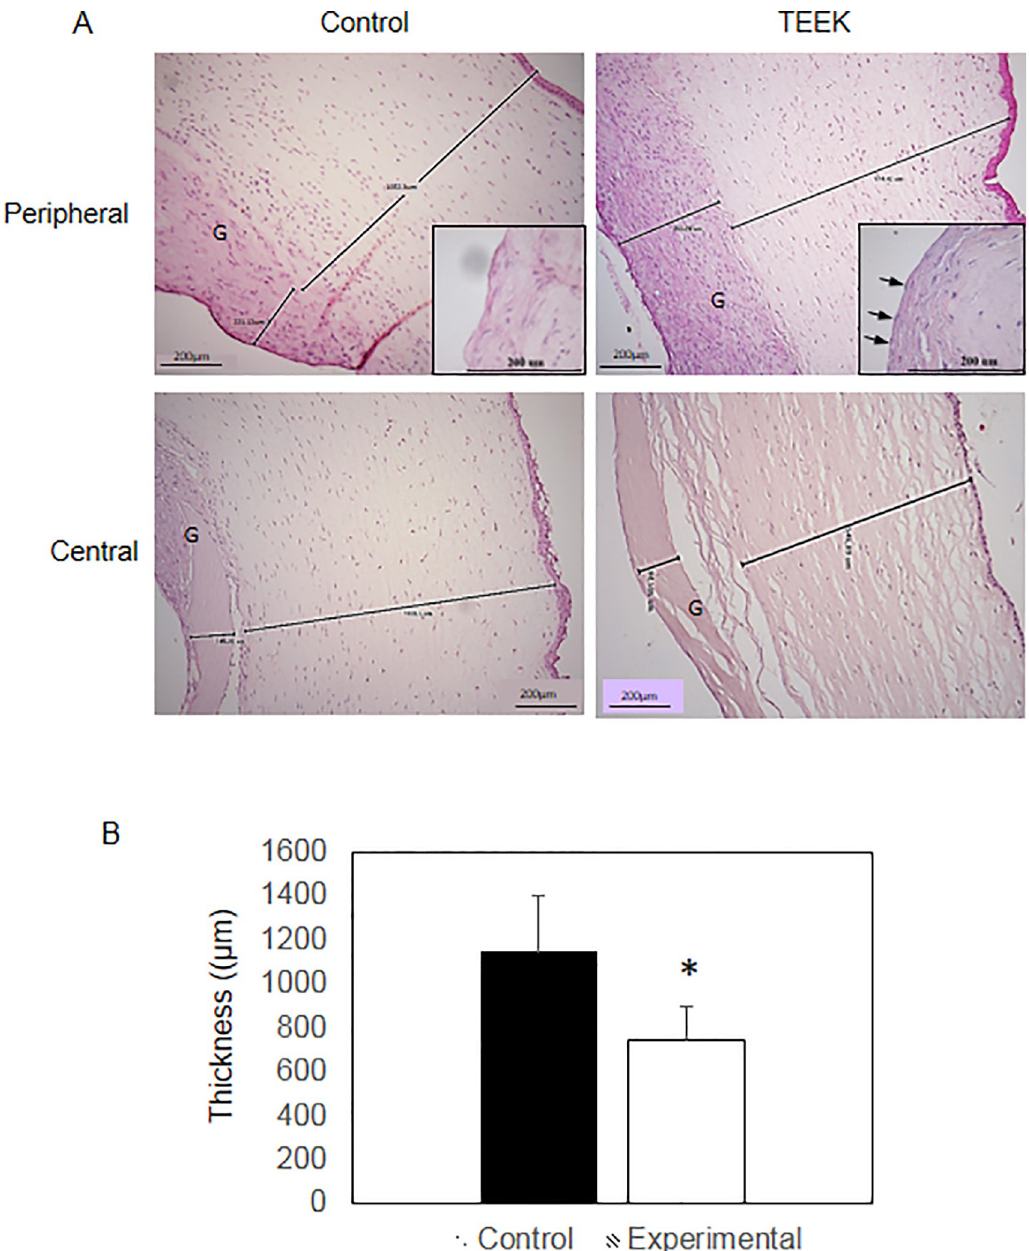
Fig 3. Histological results. Haematoxylin-eosin histological images of control and experimental (TEEK) corneas both at a peripheral section and at a central section of the cornea. Note the increased thickness of the control due to increased oedema. Graft thickness is also increased in both groups (G), and the experimental corneas shows endothelial cells. Insets show higher magnification demonstrating endothelial cells in the TEEK group (arrows). Also note the absence of leukocyte infiltration in every cornea. (B) Corneal thickness measurement graph showing decreased corneal thickness in the TEEK group at 4 weeks after the transplant. Data are given as mean ± SD Asterisk indicates statistical significance at P �